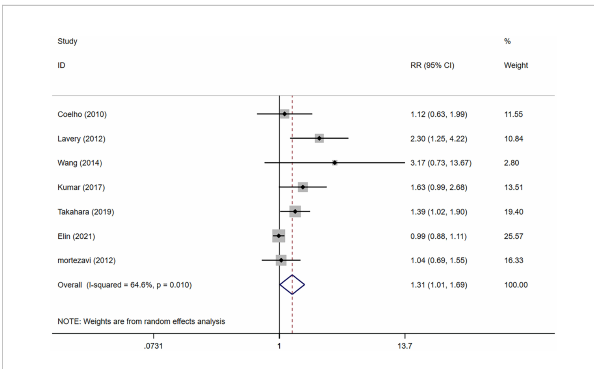
FIGURE 4 Forest plots of Oncologic Outcomes for non-nerve sparing versus nerve sparing (NS). CI, con fi dence interval; RR, Risk Ratio.